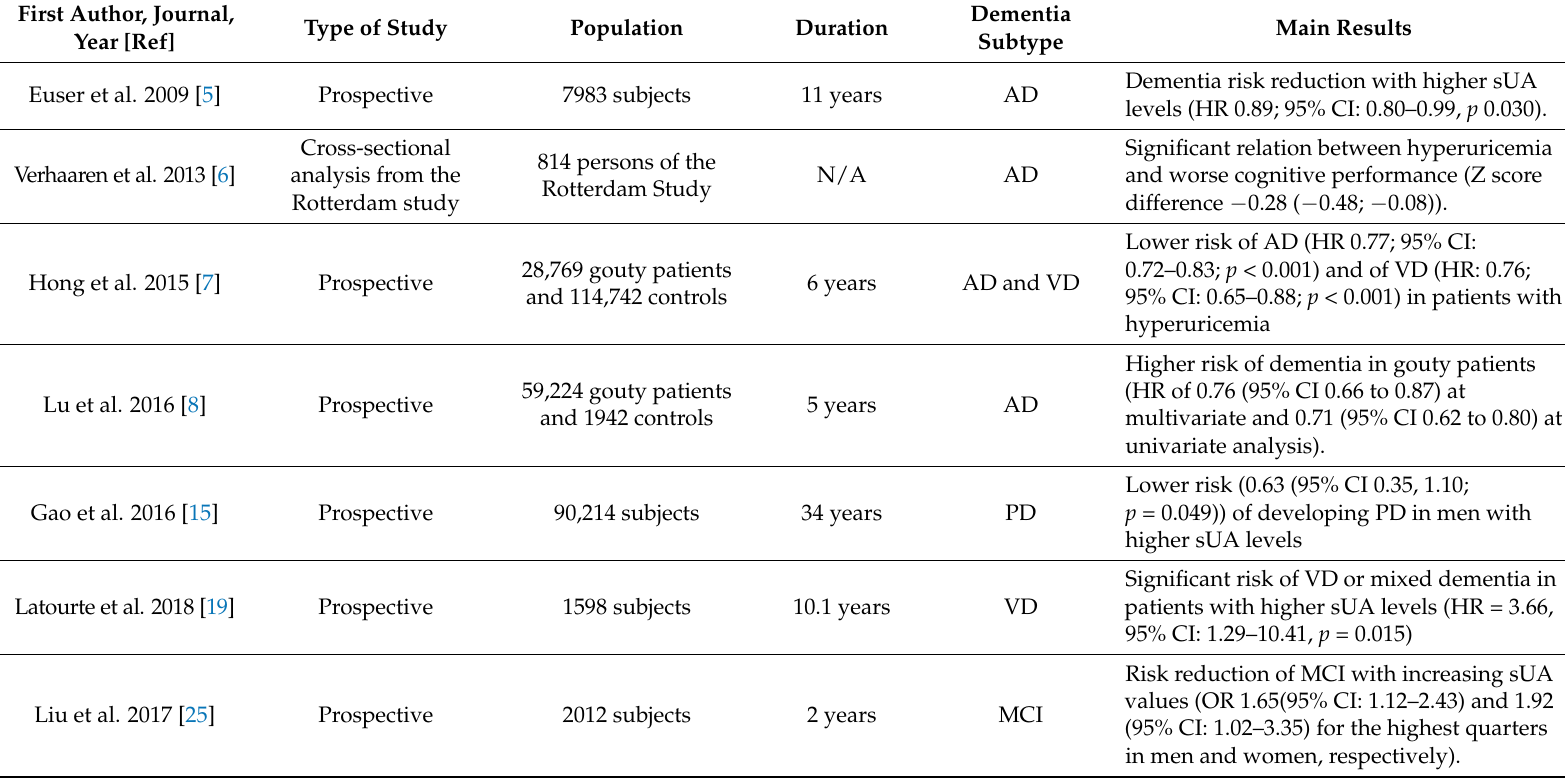
Table 1. Large studies assessing the relationship between UA and risk of